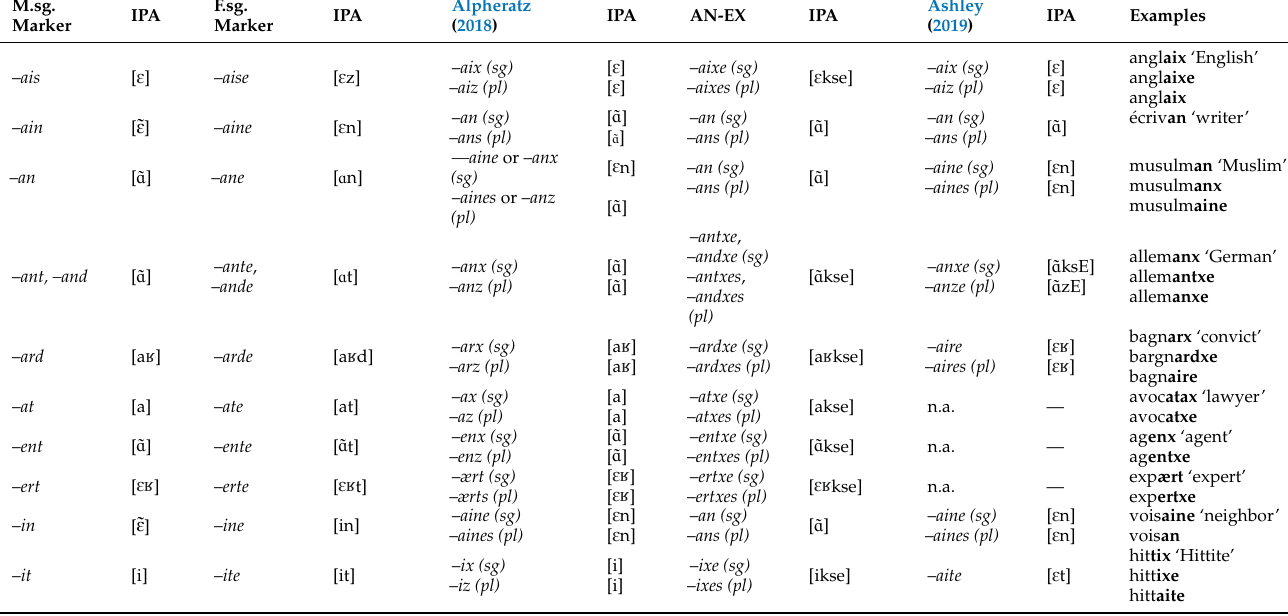
Masculine Feminine